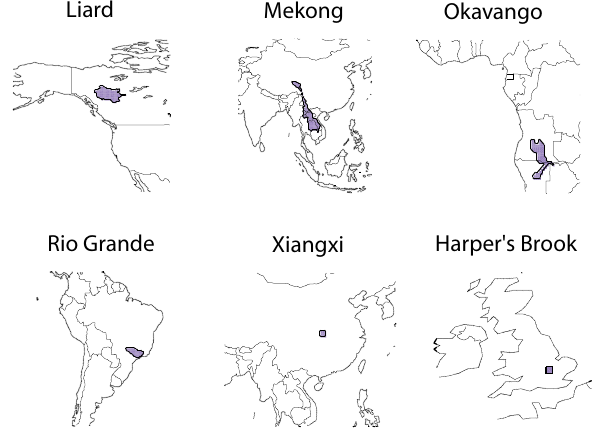
Fig. 2. Maps showing the 0.5 ◦ × 0.5 ◦ model grid cells located within the catchments we investigated. The number of cells in- cluded within each catchment is shown in Table